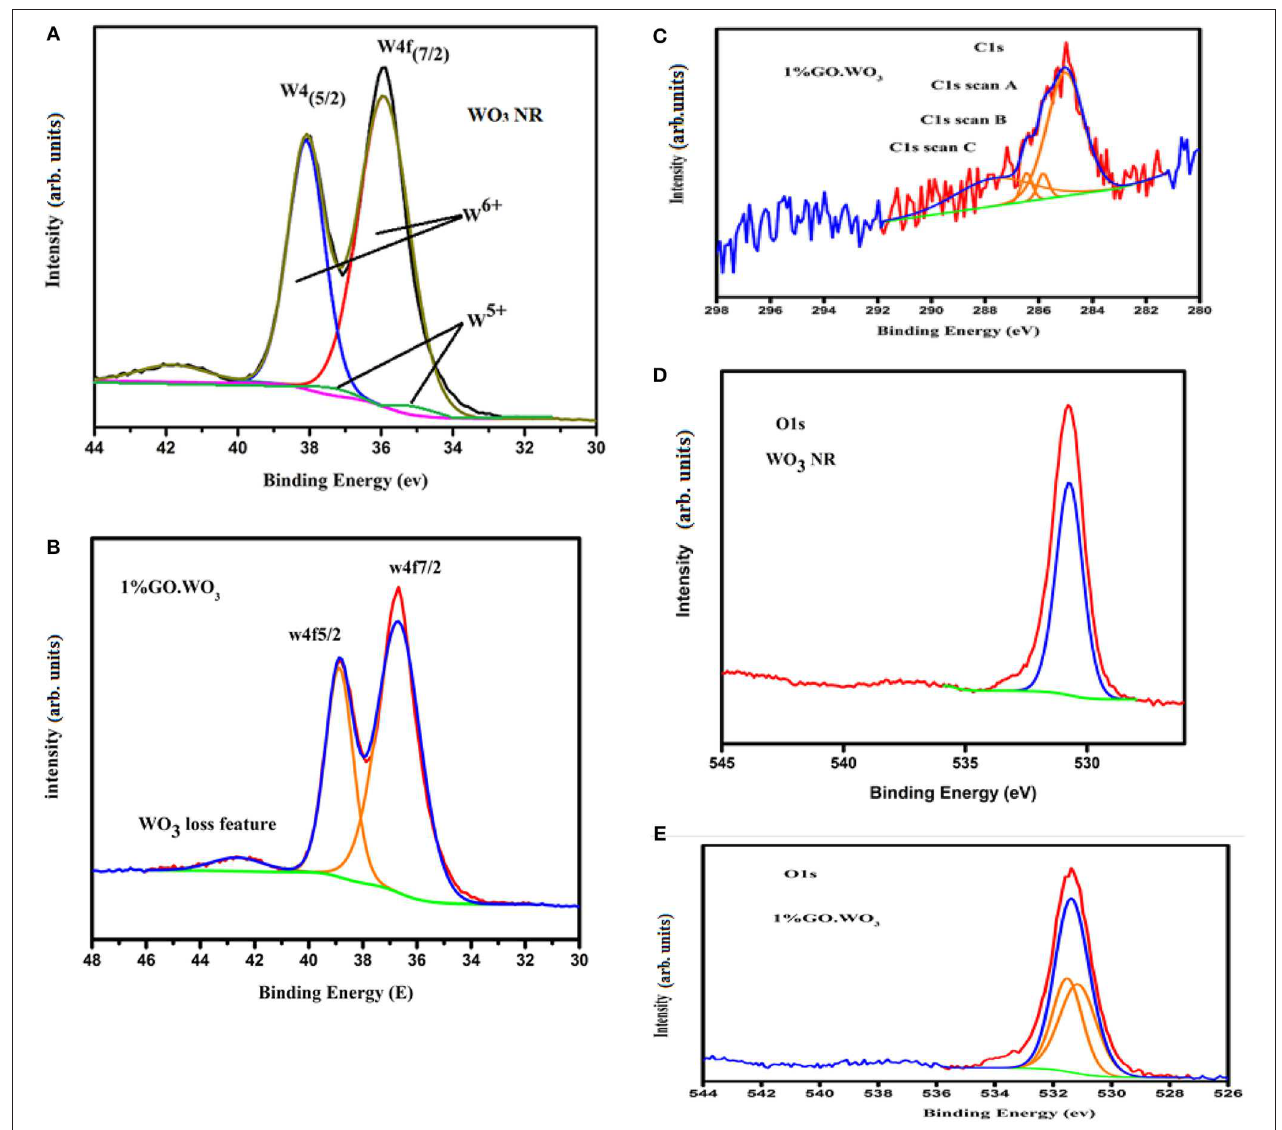
FIGURE 6 | W 4f XPS spectra of WO 3 (A) and 1%GO.WO 3 (B) , beside the C1S of 1%GO.WO 3 (C) , and O1S of WO 3 (D) and 1% GO.WO 3 (E)